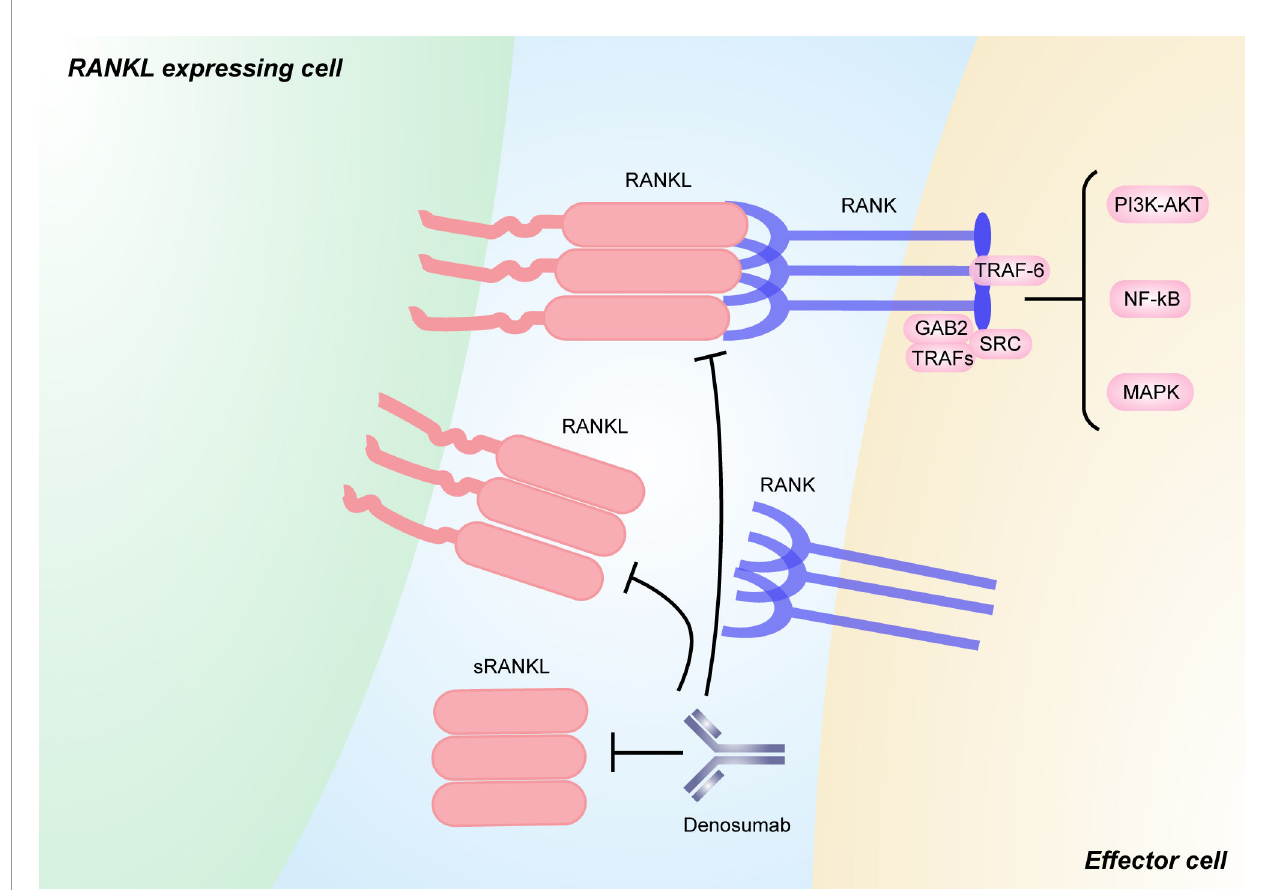
FIGURE 3 | RANKL/RANK signaling and its inhibitors. RANKL is a type II transmembrane molecule that contains a small N-terminal intracellular domain, a transmembrane region, and a c-terminal extracellular domain consisting of a stalk and a receptor-binding region [111]. sRANKL is derived from the membrane- bound form through alternative splicing or proteolytic cleavage. Binding between RANKL and RANK induces the recruitment of TNF receptor associated (TRAF) proteins (including TRAF6), GRB-associated-binding protein 2 (GAB2), and SRC, which activates downstream signaling pathways, such as NF- k B, MAPK, and PI3K – AKT pathways. Pharmacological inhibitors targeting both soluble and membrane-bound forms of RANKL that have been used in humans include the anti- RANKL monoclonal antibody denosumab. The fi gure was designed using Adobe Illustrator